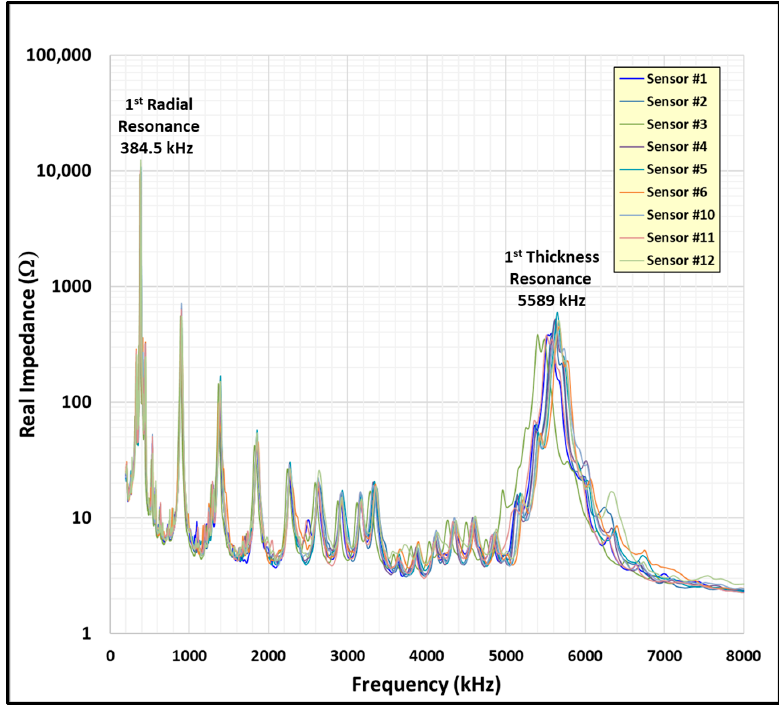
Figure 4. Free sensor real impedance responses.